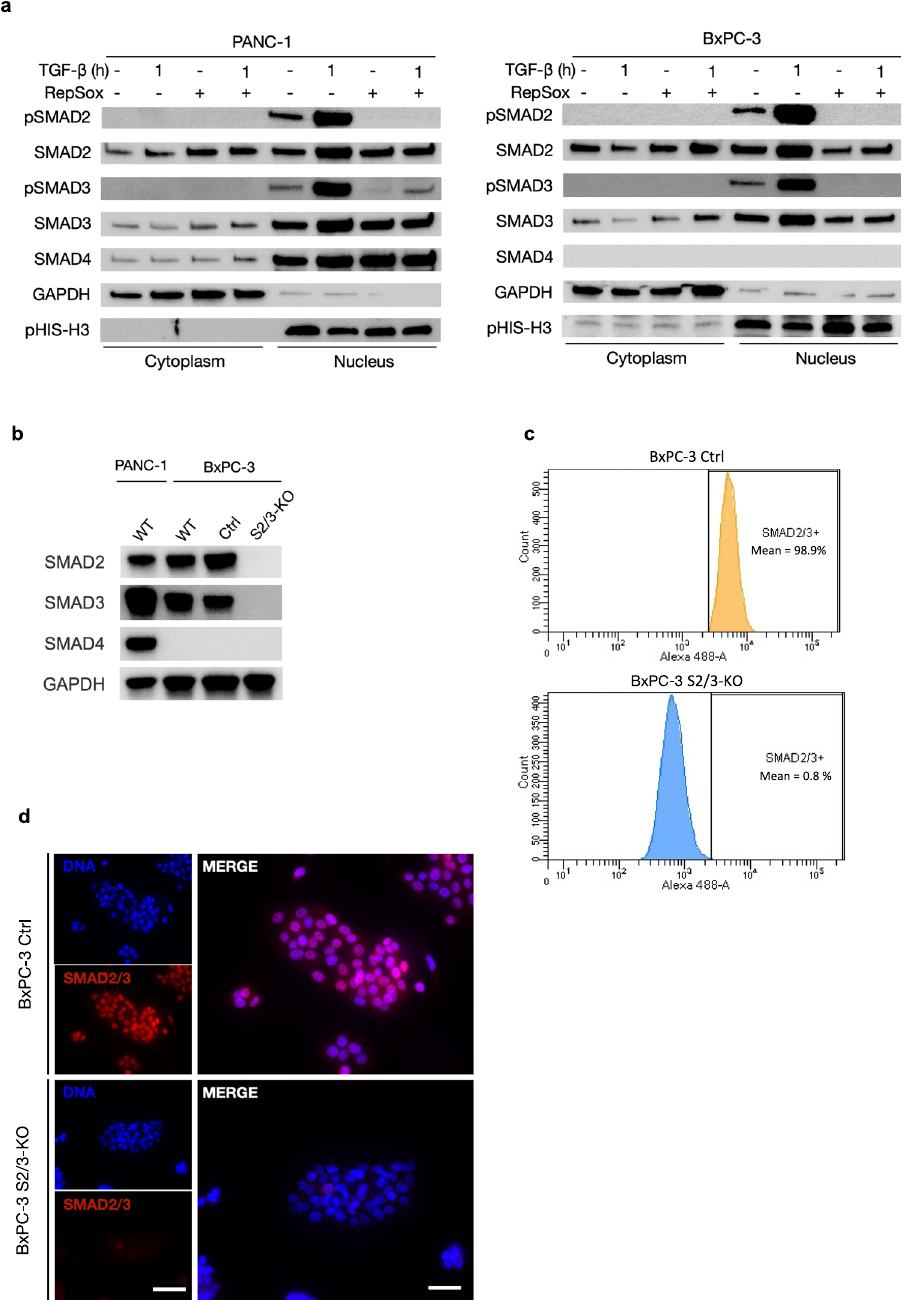
Fig. 1 Generation of a double SMAD2/SMAD3 knockout BxPC-3 (SMAD4-negative) pancreatic cancer cell line. a Immunoblot of phospho-SMAD2 (pSMAD2), SMAD2, phospho-SMAD3 (pSMAD3), SMAD3 and SMAD4 after treatment with TGF- β and/or TGF- β R1 kinase activity inhibitor (RepSox) for 1 h on cytoplasmic (GAPDH as control) and nuclear fractions (phospho-histone H3 (pHIS-H3) as control) prepared from SMAD4-positive PANC-1 cells (left panel) and SMAD4-negative BxPC-3 cells (right panel). One representative image out of 3 independent experiments is shown. b Immunoblot of SMAD2, SMAD3, SMAD4 and GAPDH on PANC-1 (SMAD4 + ), BxPC-3 (SMAD4 - ) wild-type (WT), control (Ctrl) and SMAD2/SMAD3-knockout (S2/3- KO) cells obtained by CRISPR/Cas9 genome editing technique. One representative image out of 3 independent experiments is shown. c Flow cytometric analysis of SMAD2/3 performed on control and S2/3-KO BxPC-3 cells. SMAD2/3 ratio was determined as the mean value of three independent experiments. d Immuno fl uorescent micrographs of SMAD2/SMAD3 staining on control and S2/3-KO BxPC-3 cells treated with TGF- β (1 h). Nuclei were counterstained in blue with DAPI. Representative images out of 3 independent experiments are shown. Scale bar (left-hand images) = 50 µ m. Scale bar (right-hand images) = 20 µ